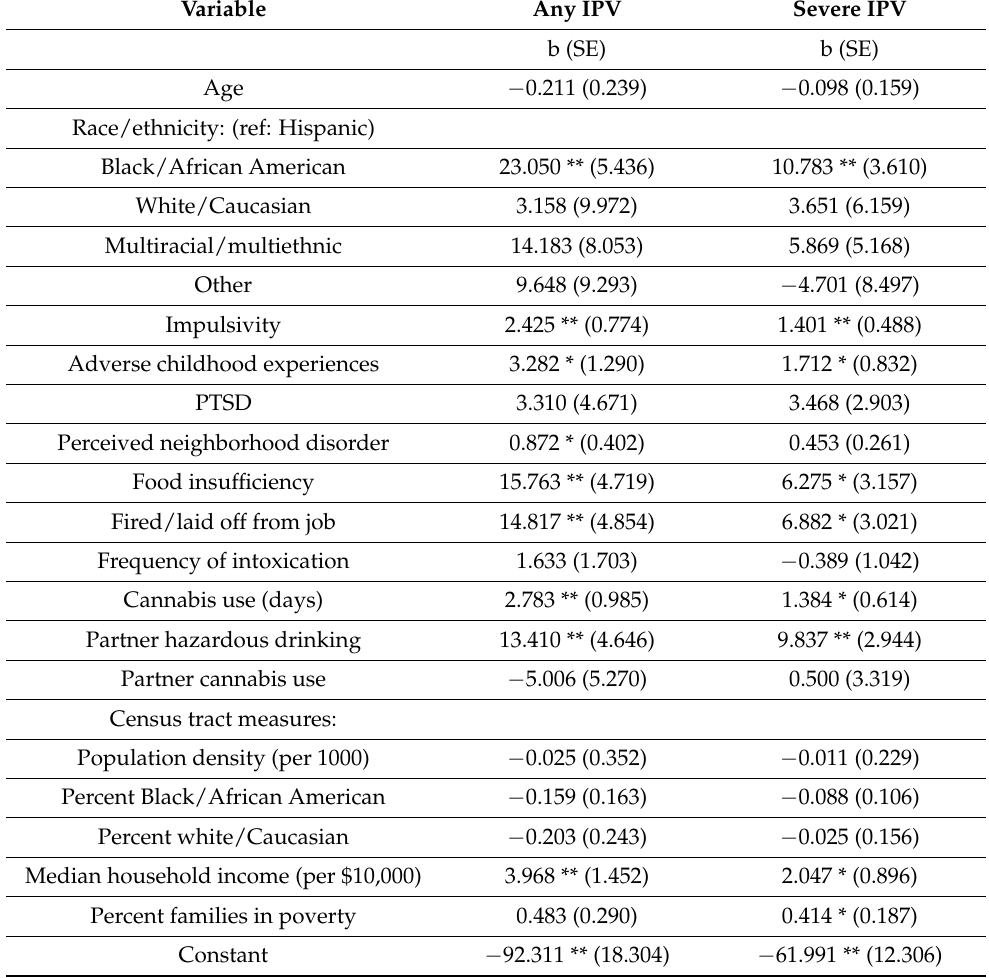
Table 2. Correlates of IPV frequencies among women ( n = 496 in 144 Census tracts).